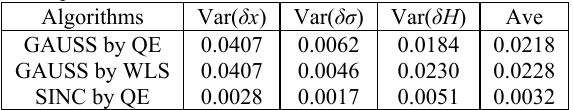
Table 1. Fluctuation analysis of three algorithms